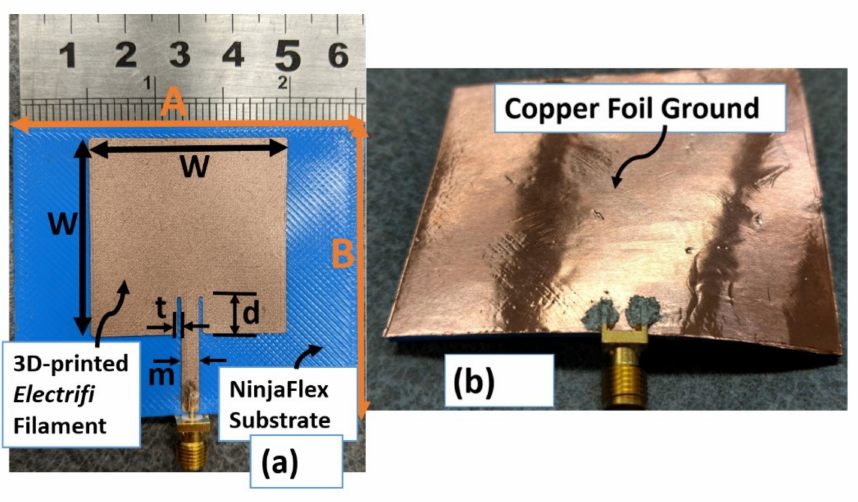
Figure 7. Photograph of the fabricated microstrip patch antenna prototype: ( a ) top view; ( b ) bot- tom